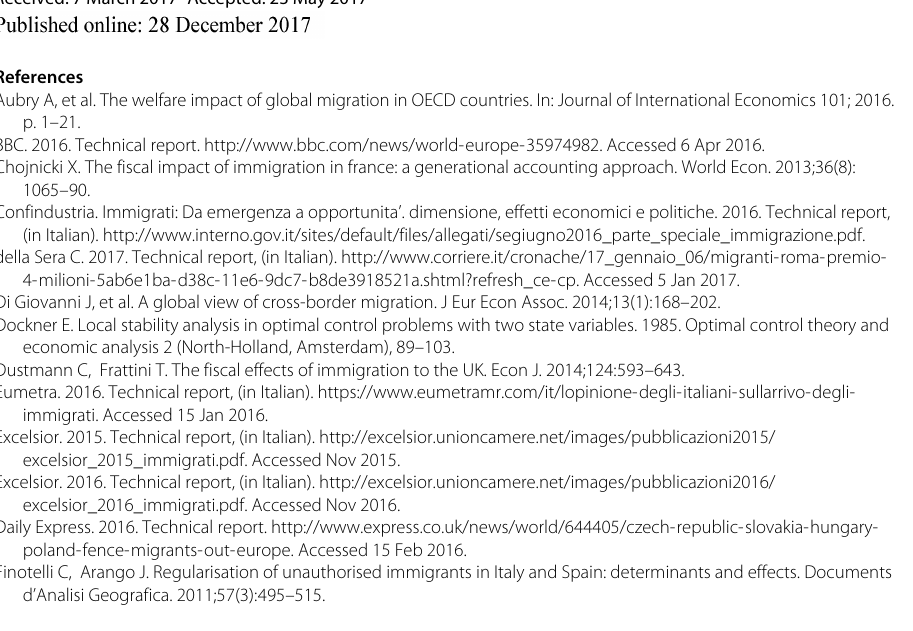
˙ π > 0, at any point to the left(/right) of the ˙ π = 0 locus, π increases (/decreases) in since ψ the horizontal direction. Figure 1 provides the phase diagram for the dynamics of convergence towards the steady state, with the level of rigidities being null (i.e., γ = 0). The intersection point of the two isoclines denotes the steady-state level of overcongestion, with the bold line representing the optimal monotonic trajectories of immigration flows and